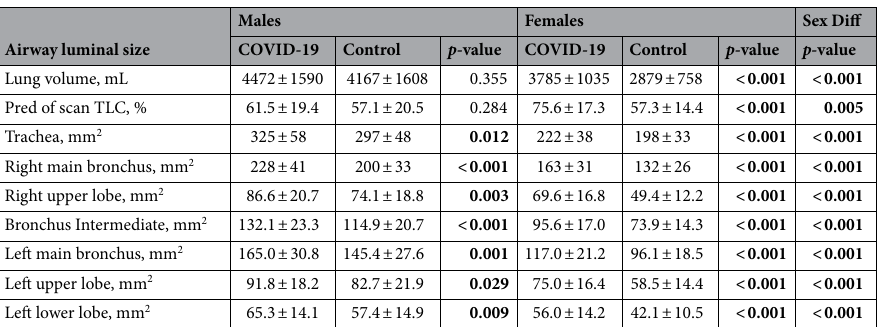
Table 2. Airway size of males and females previously diagnosed with COVID-19 and a height- and age- matched control cohort. Data are reported as mean ± standard deviation (SD). Data are compared using one- way analysis of variance. p -values are reported for between group comparisons (COVID-19 vs. control) for males and females separately, and between sex comparisons (males vs. females) for both groups pooled. Pred of scan TLC, predictive relation lung volume based on the computed tomography scan, absolute measured volume, and predicted total lung capacity. Significant values are in bold.